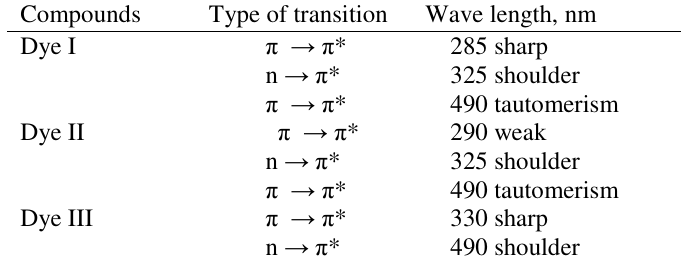
Figure 5. UV-Visible curves of compounds (I, II and III) Table 2. Types of UV-Visible transition